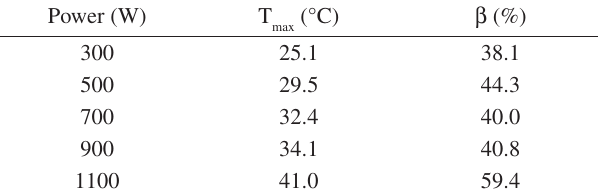
Table 2. Experimental data from the calorimetric tests. Power